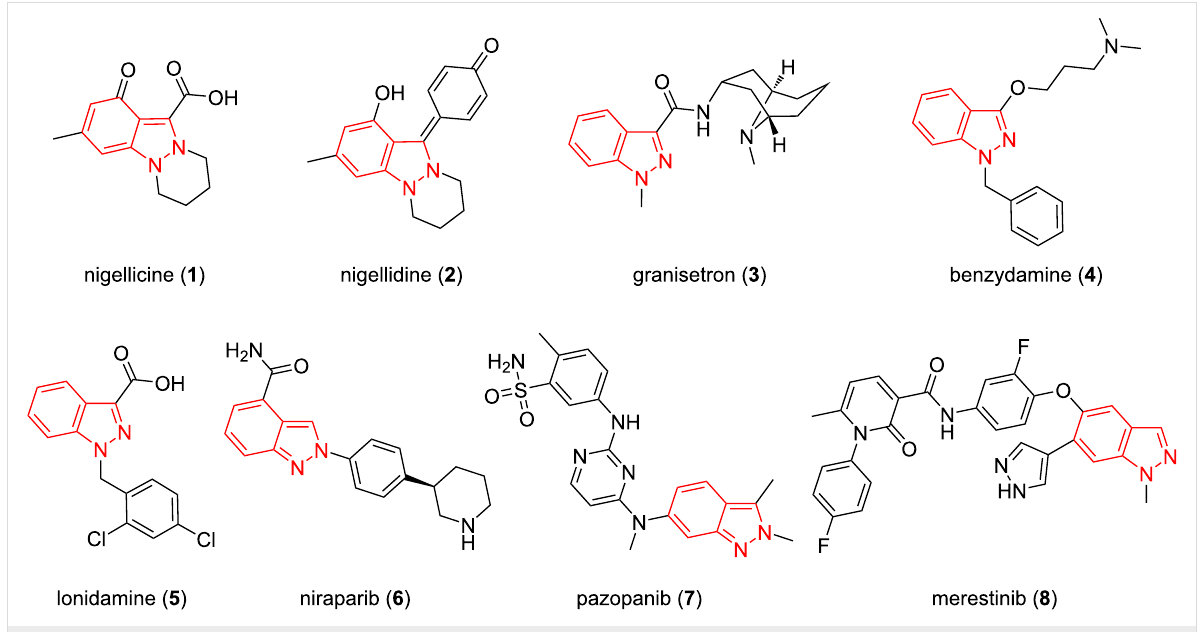
Figure 1: Examples of indazole natural products ( 1 and 2 ) and synthetic biologically active indazole derivatives ( 3 – 8 ).